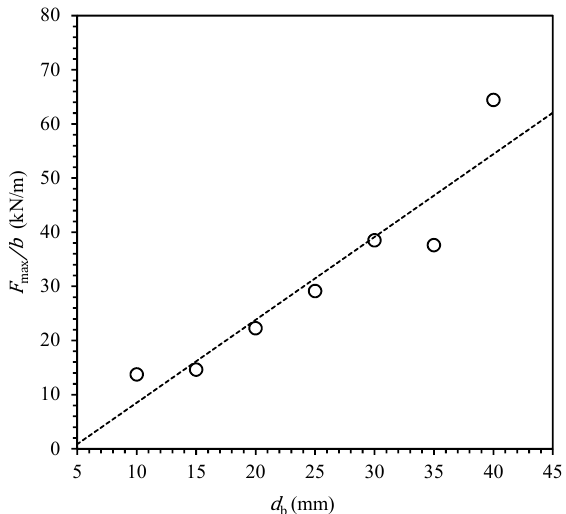
Fig. 5 The maximum force over joint length against the bite depth for a 45° pulling angle and a speed of 1m/s.